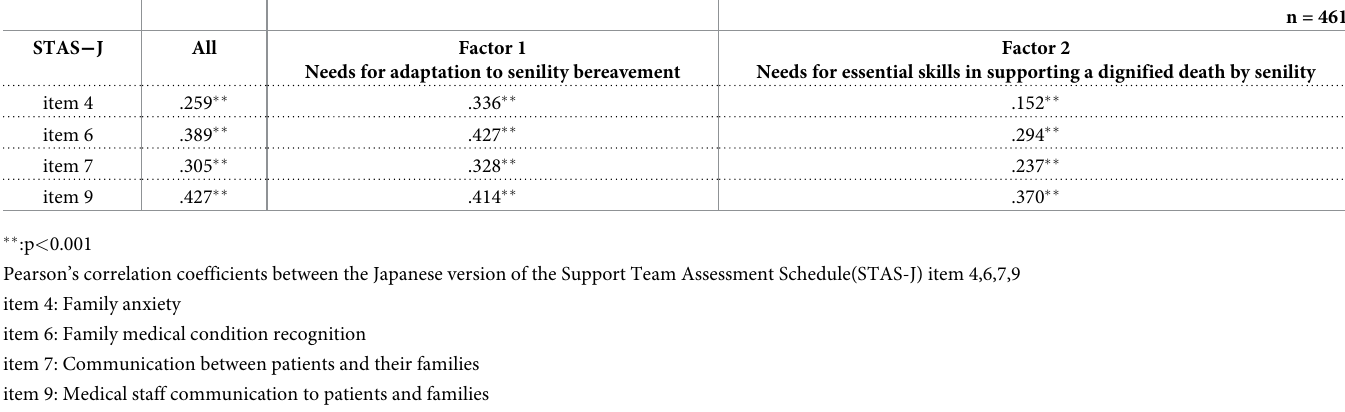
Table 5. Construct validity of the "Family caregiver needs-assessment scale for end-of-life care for senility at home". STAS ―